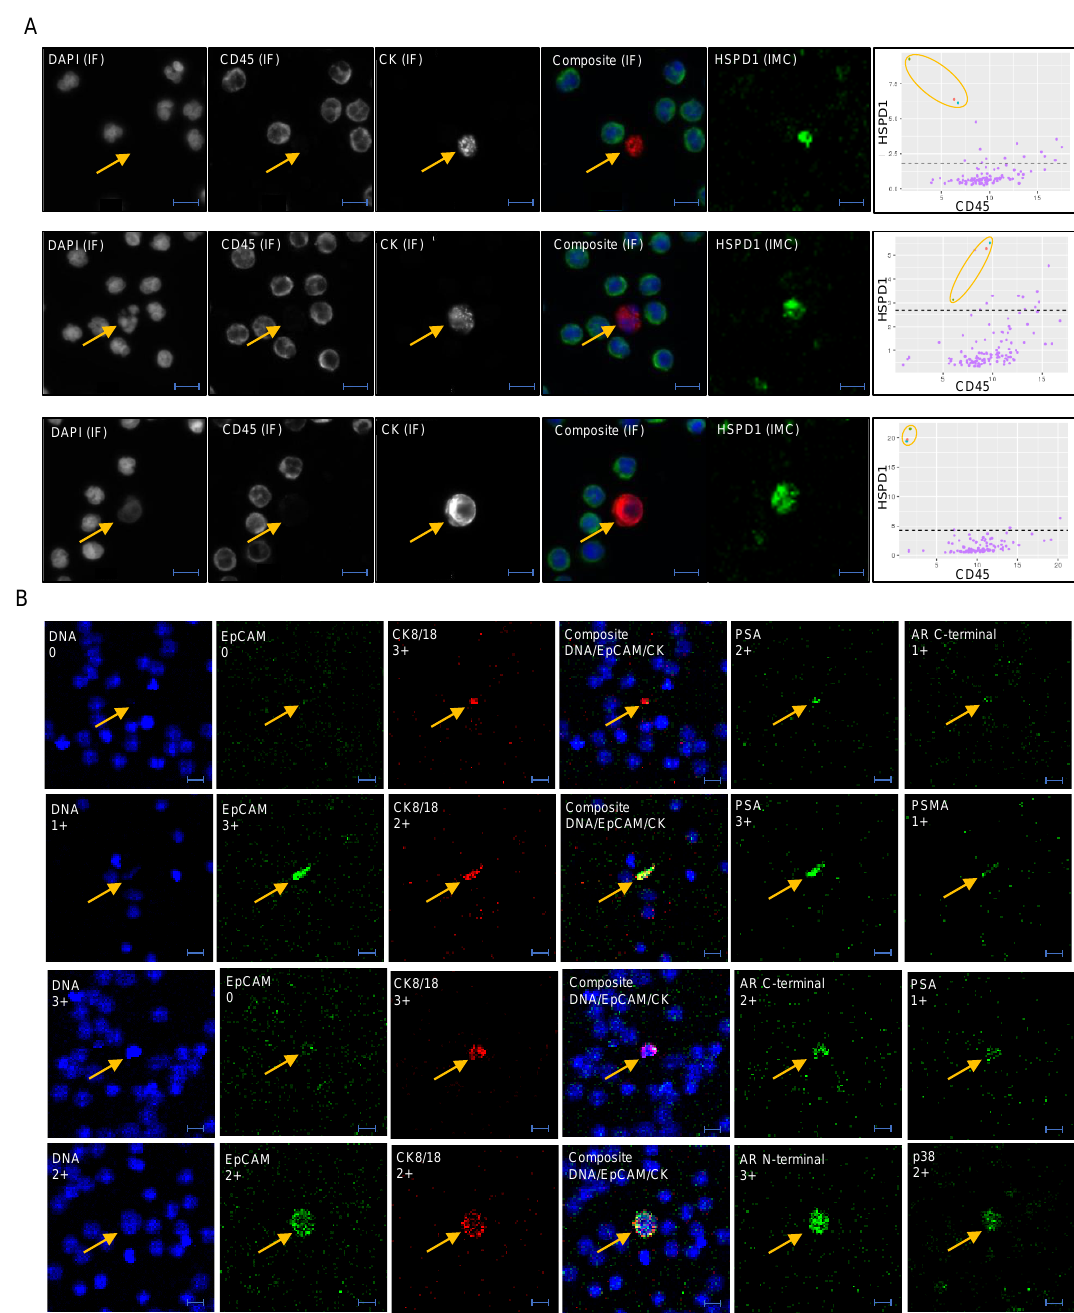
Figure 3. Biomarker expression in CTCs and LEVs of AVPC. ( A ) Example of HSPD1 expression in LEV (top panel), apoptotic (middle panel) and CTC (bottom panel). Cropped ROI images are shown with individual IF channels and IF composite image with DAPI (blue), CD45 (green) and pan-CK (red). The IMC rendered image of HSPD1 signal is shown in green. Table 1 vs. CD45 for all objects within the full ROI with WBCs in purple and the cell of interest (circled) in red (full cell), green (cytoplasm) and teal (nucleus). ( B ) Selected biomarkers shown for LEVs (top 2 panels) and CTCs (bottom 2 panels), with EpCAM expression varying from negative (0) to strong (3+). Scores from the 0–3 scale is shown for each marker and object. Scale bar is 10 µ